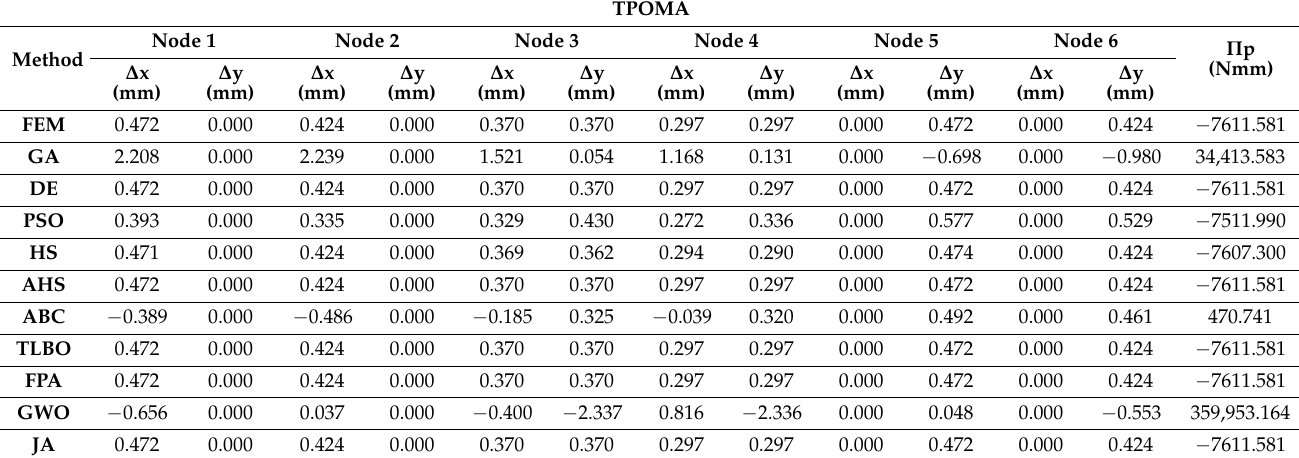
Table 1. Optimization results for the structural system with 4 members-6 nodes (linear).